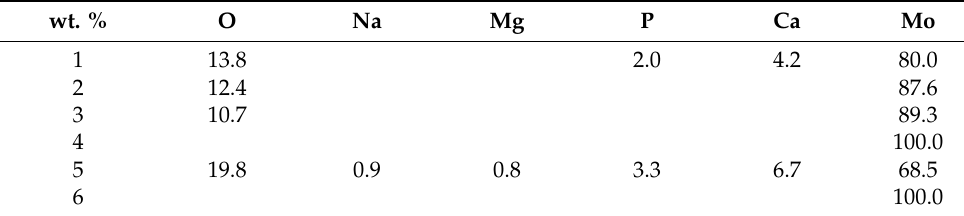
Figure 2. PM Mo sample in sample holder ( a ), photographs of corroded PM Mo ( b ) and CA Mo ( c ), optical micrographs of microstructure ( d , g ), corroded surface ( e , h ), and cross section ( f , i ) of PM Mo and CA Mo, respectively, after 28 days immersion in c-SBF-Ca. Table 5. Results of EDX analyses at locations indicated in Figure